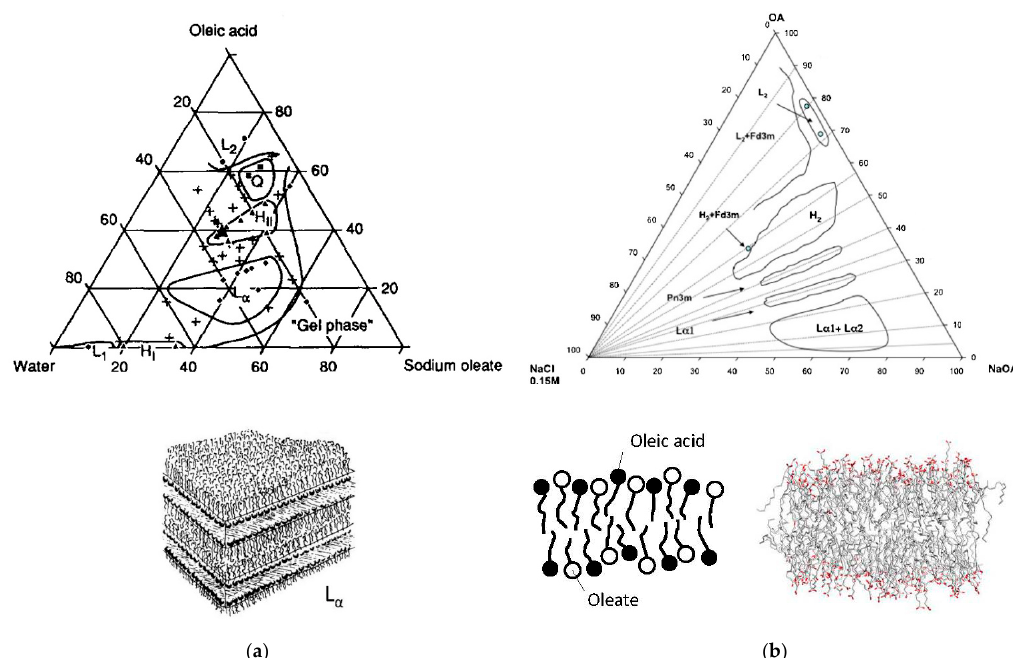
Figure 4. Aqueous mixtures of oleic acid and sodium oleate at T = 20 or 25 °C. ( a ) Top : Ternary phase diagram of oleic acid/sodium oleate/water for T = 20 °C, as published by Engblom et al. (1995) [56]; L 1 , (normal) micellar phase; H I , (normal) hexagonal phase; L α , lamellar phase; H II , inverse hexagonal phase; Q, cubic phase; L 2 , inverse micellar phase. Bottom: Sche- matic representation of a lamellar phase (L α ) [53]. ( b ) Top : Ternary phase diagram of oleic acid (OA)/sodium oleate (NaOA)/0.1 M aqueous NaCl at T = 25 °C, as published by Mele et al. (2018) [57]; L α 1 and L α 2, two different lamellar phases; Pn3m, inverse bicontinuous cubic phase; H 2 , inverse hexagonal phase; Fd3m, inverse micellar cubic phase; L 2 , inverse micellar phase. In practice, the lamellar phase appears as multilamellar vesicles [57]. Self-closure into bilayers eliminates unfavorable interactions between the hydrophobic part and water at the edges of a planar bilayer. Bottom: Schematic representation of an oleic acid/oleate bilayer (1:1 molar ratio) with a snapshot from a molecular dynamics sim- ulation, as published by Han (2013) [59]. Reproduced with permission from [56], Elsevier, 1995; from [53], Society of Cos- metic Chemists, 1968; from [57], Elsevier, 2018; and from [59], Elsevier, 2013.